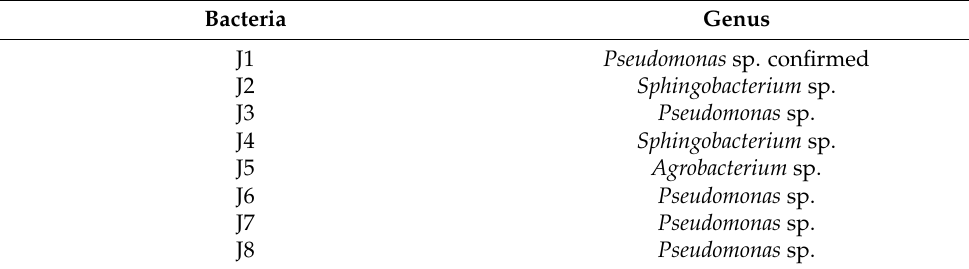
Table 1. Bacteria isolated from BBR-degrading soil